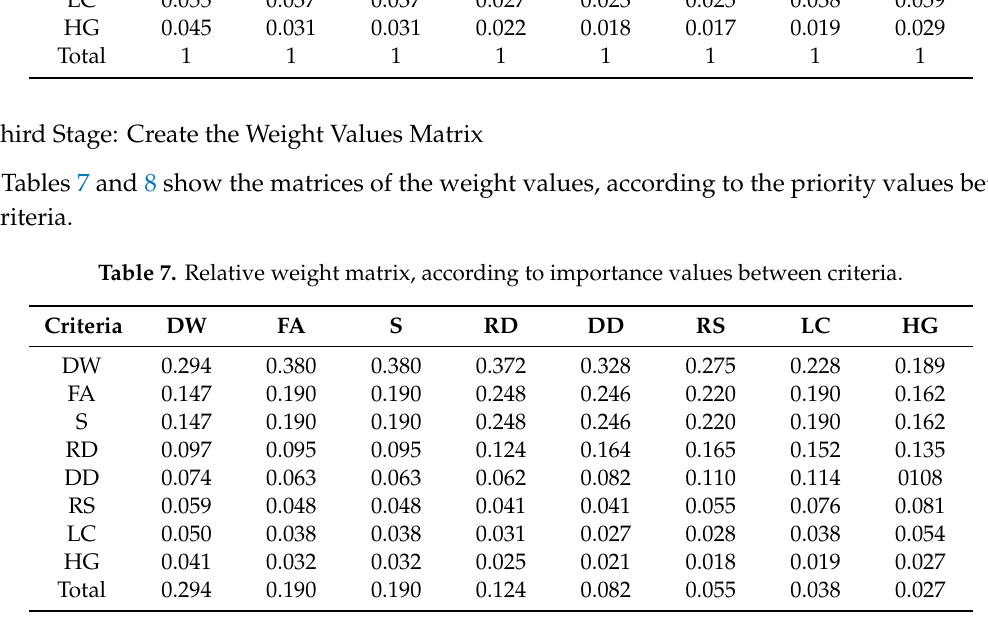
Table 8. Weight values of each criteria using AHP.